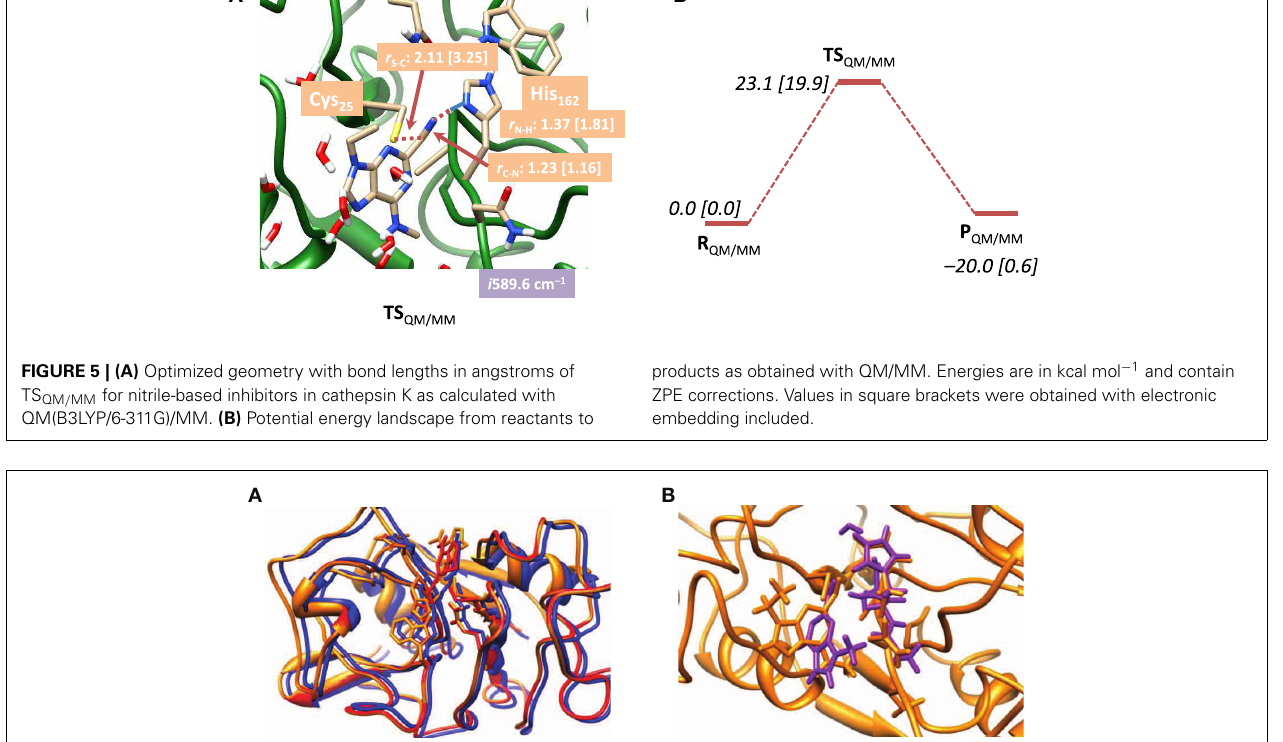
FIGURE 6 | (A) Overlay of optimized geometries of R QM / MM (red), TS QM / MM (amber) and P QM / MM (blue) structures. (B) Overlay of TS QM / MM (amber) and TS E , S1 (violet). QM/MM structures obtained with mechanical embedding